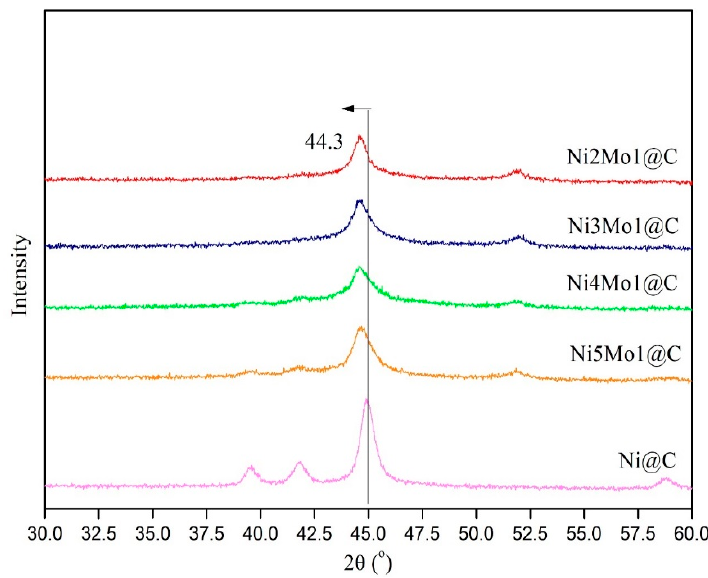
Figure 1. XRD patterns of Ni@C, Ni2Mo1@C, Ni3Mo1@C, Ni4Mo1@C, and Ni5Mo1@C.